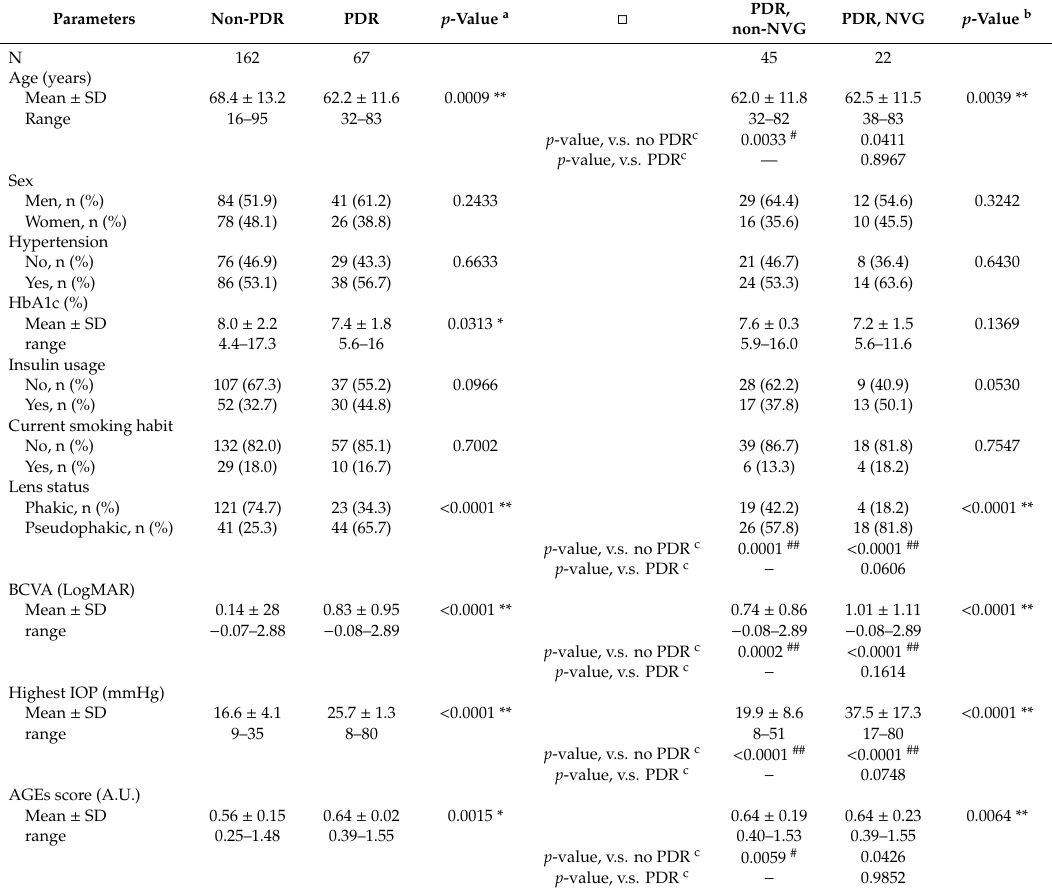
Table 4. Demographic data of DR subjects stratified by presence / absence of